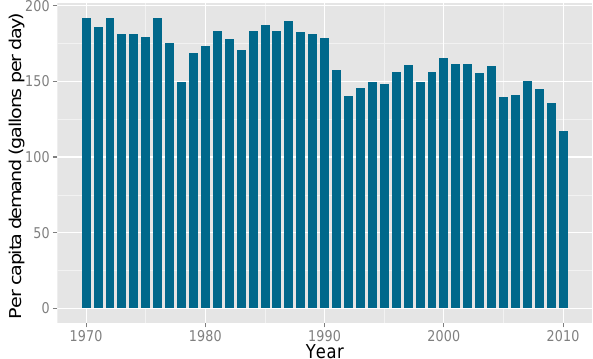
Figure 4. Historical city of Los Angeles water use (LADWP,